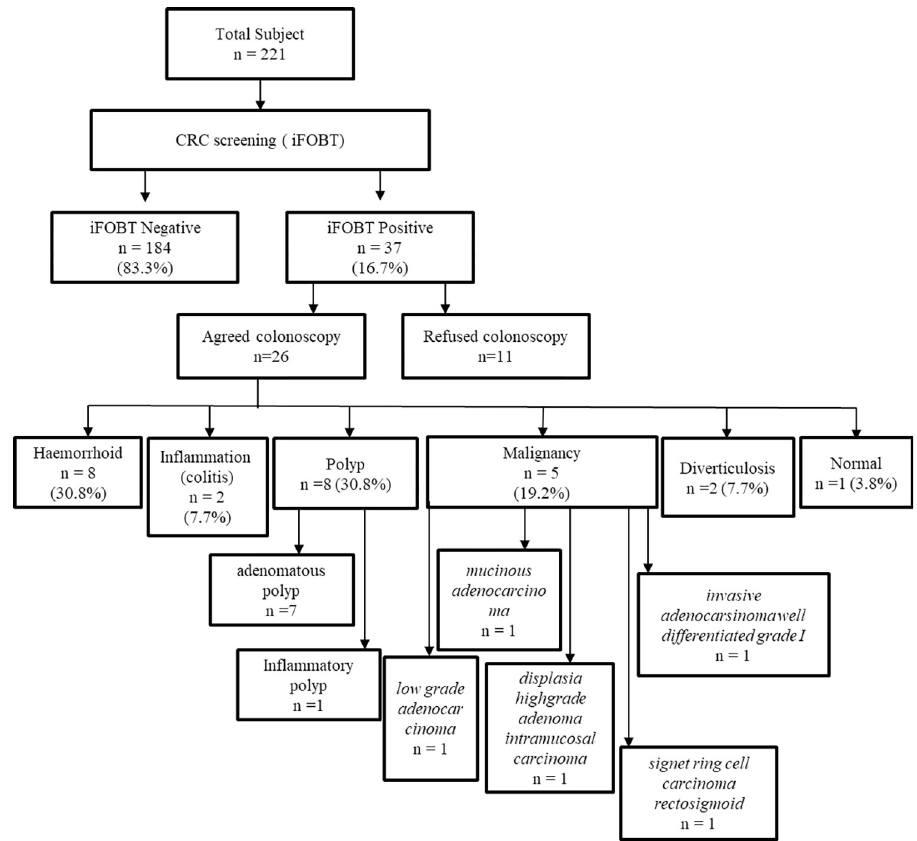
Fig 1. Study flow chart, screening results and followed up